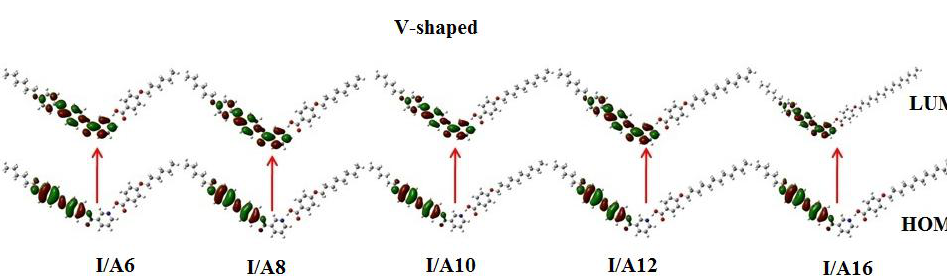
Figure 9. The estimated plots for frontier molecular orbitals of V-shaped conformer of HBSMCs, I/An. Table 3. FMO Energies a.u., polarizability, α, and dipole moment μ (Debye) of geometrical conformers of HBSMCs, I/An. Parameters